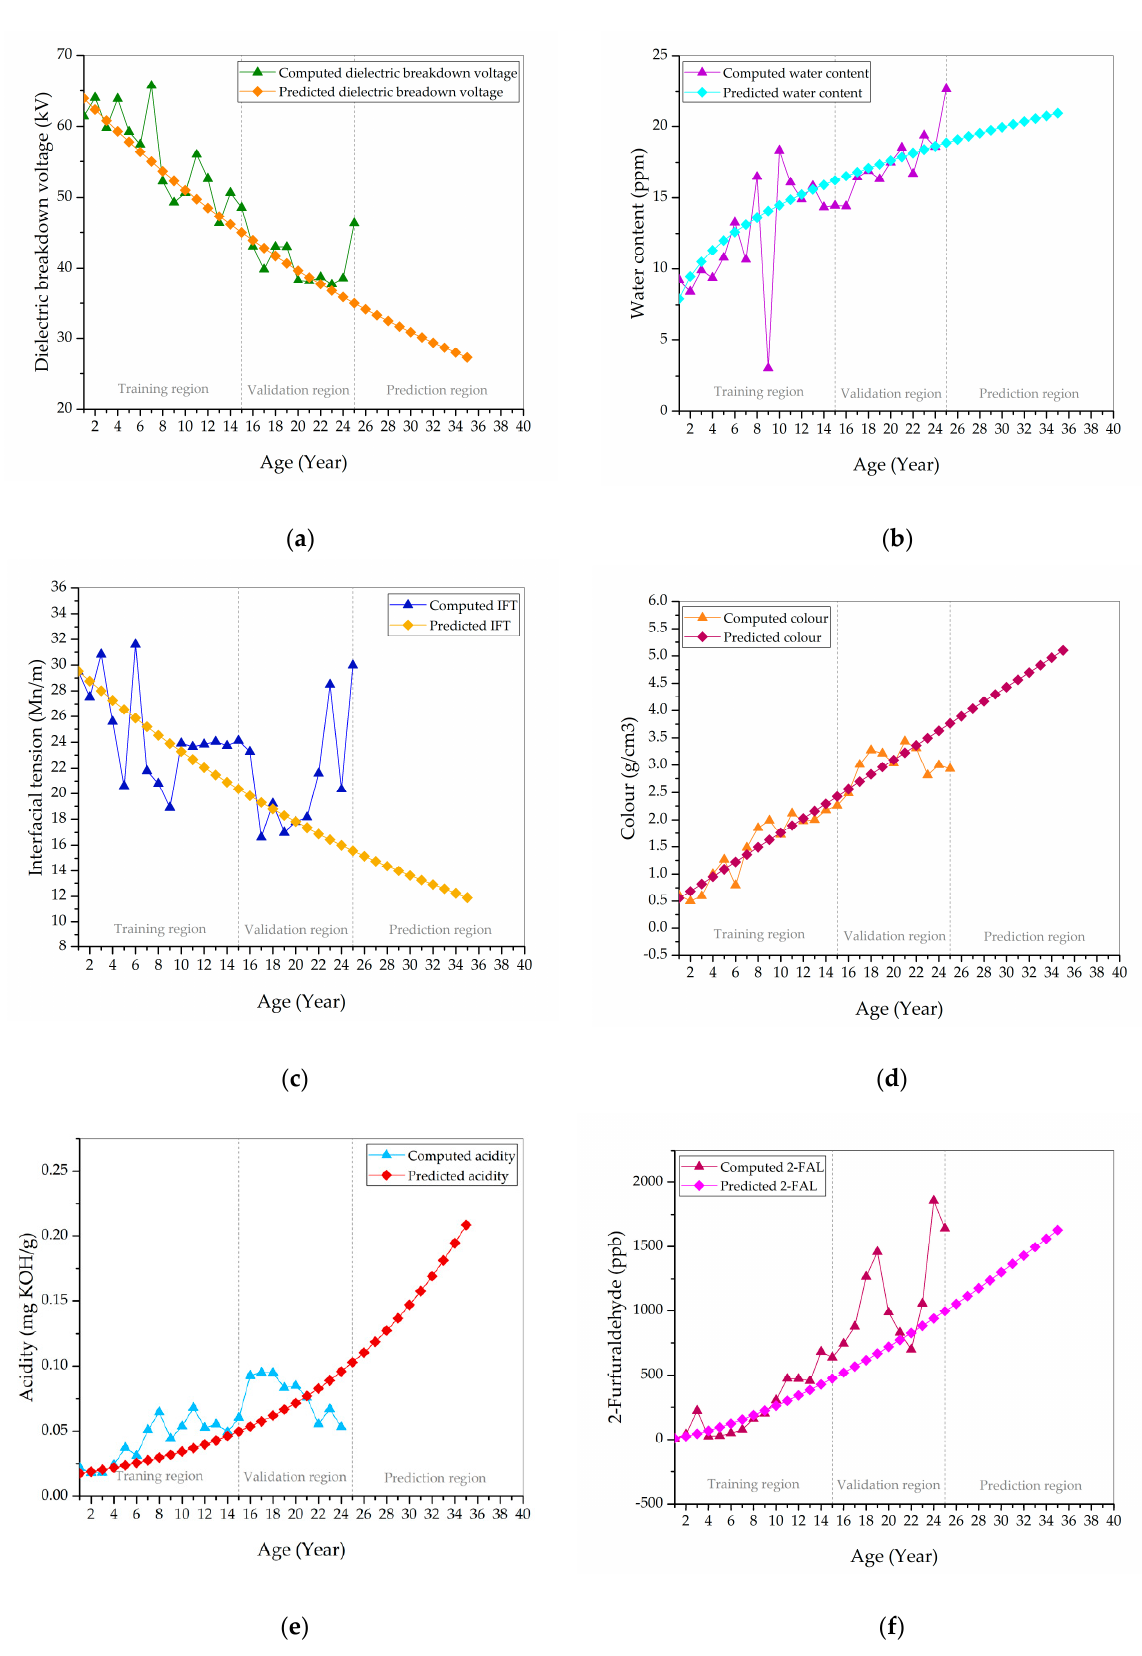
Figure 6. Comparison between computed and predicted ( a ) dielectric breakdown voltage; ( b ) water content; ( c ) interfacial tension; ( d ) color; ( e ) acidity; and, ( f ) 2-furfuraldehyde.